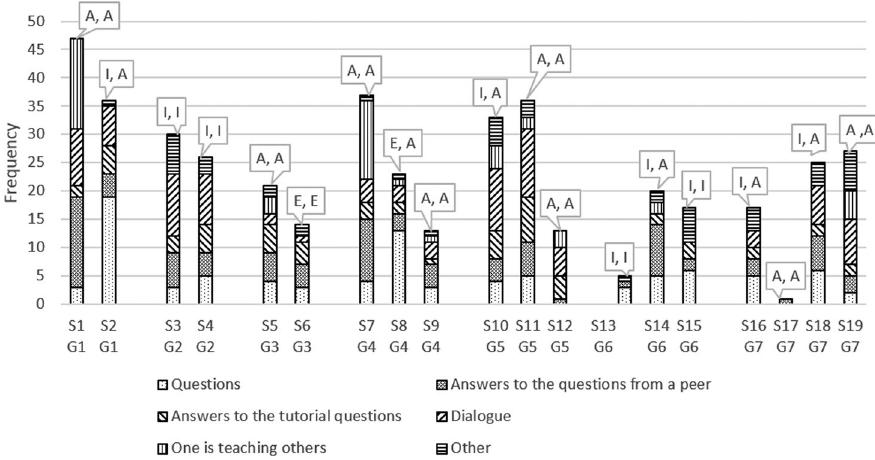
FIG. 4. A substructure of the category “ discussions related to the physics content. ”